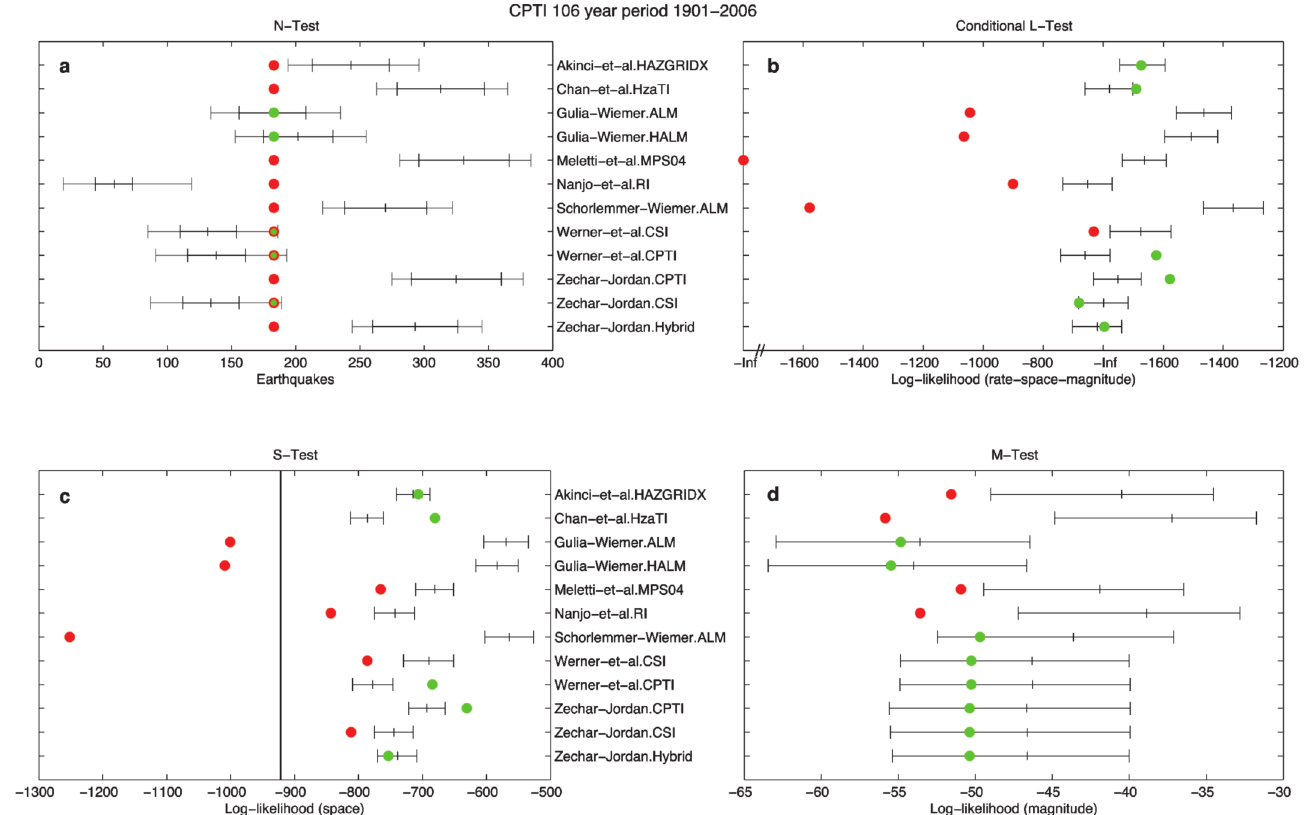
Figure 7. Results of the (a) N-Test, (b) conditional L-Test, (c) S-Test and (d) M-Test of the scaled 10-year time-independent forecasts using the 106-year target period from 1901 to 2006 of the data from the CPTI. Symbols and bars as given in the legend to Figure 1.